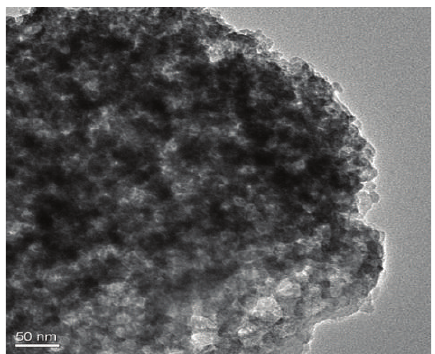
Figure 5: TEM images of feedstock.